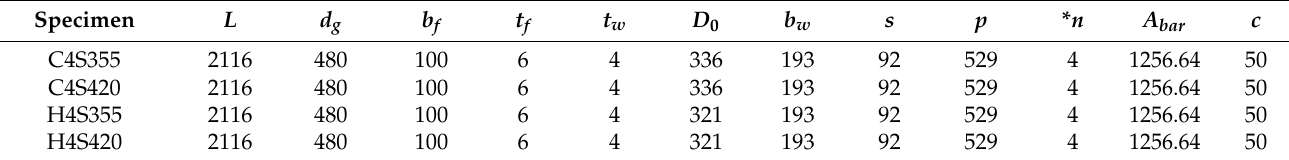
Table 10. Mechanical properties and ultimate load of the specimens.